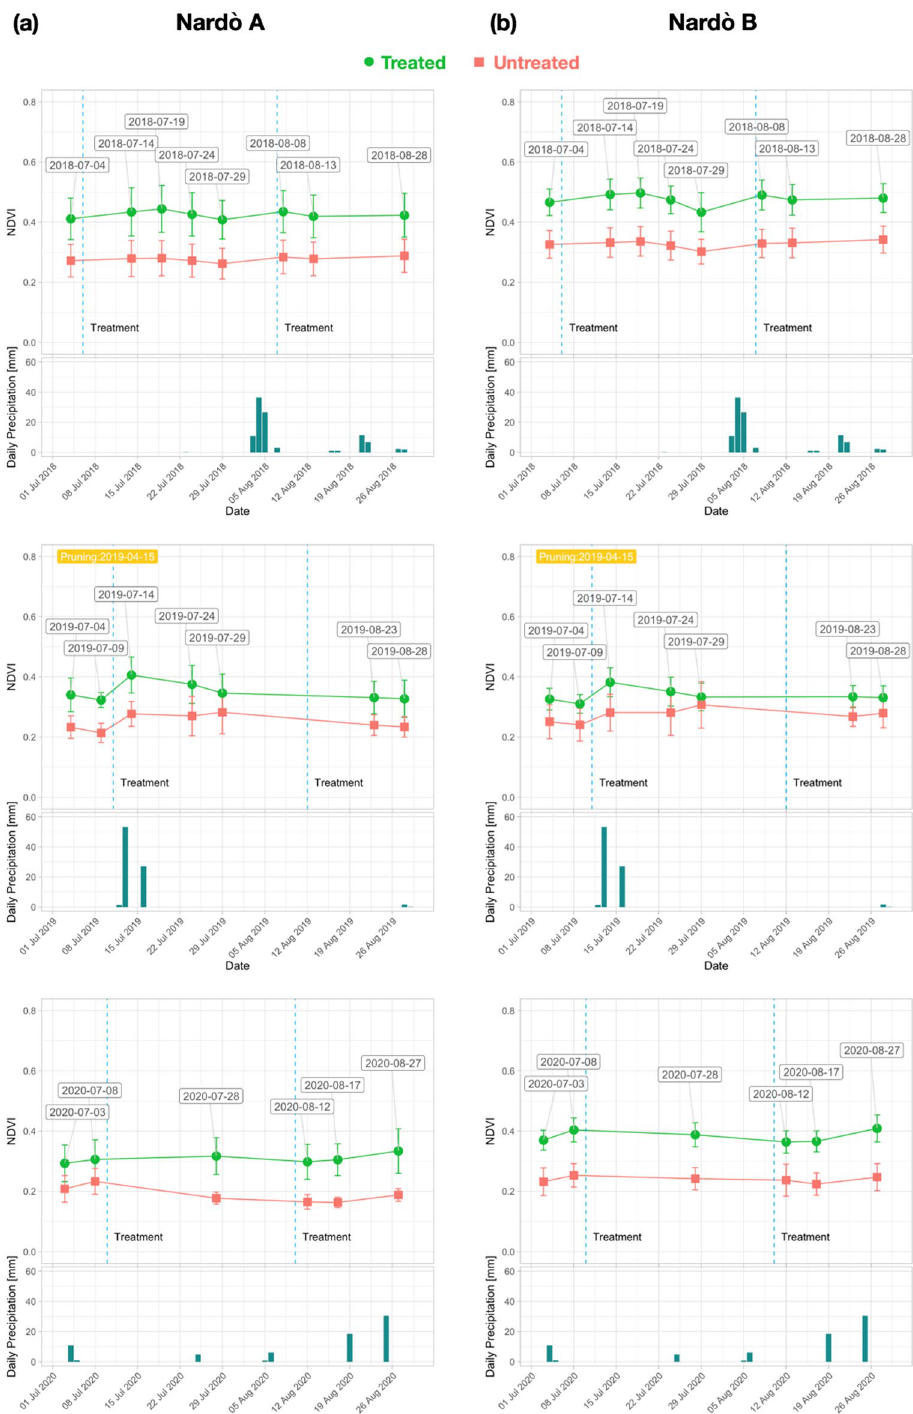
Figure 9. NDVI trend for each year (2018–2020) from S-2 date: ( a ) Nardò A; ( b ) Nardò